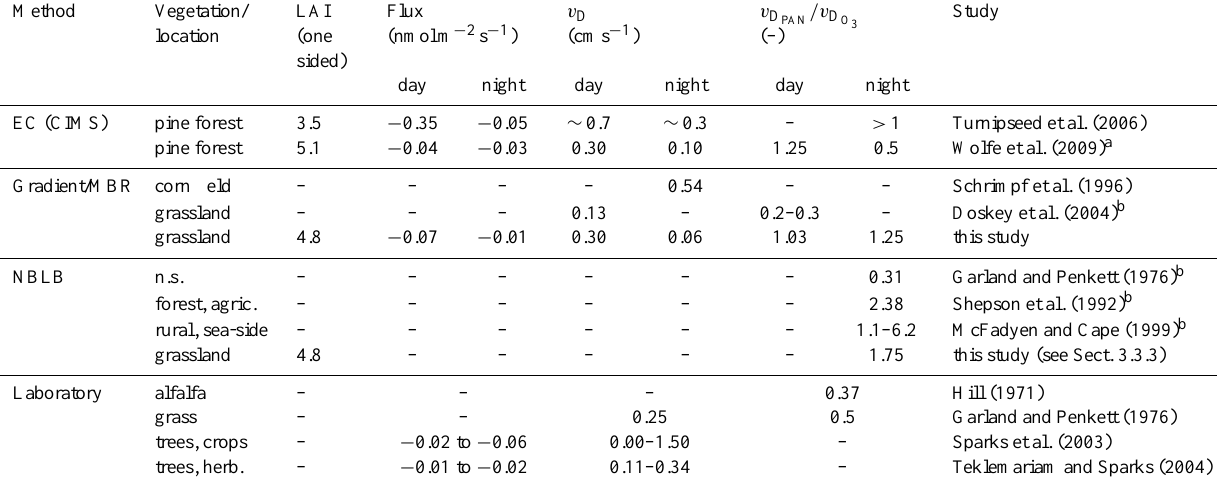
Table 1. Comparison of PAN fluxes and deposition velocities at the Mainz Finthen grassland with previous studies. All field experiments were performed in the mid-latitudes of the Northern Hemisphere within the period of late spring to early autumn.